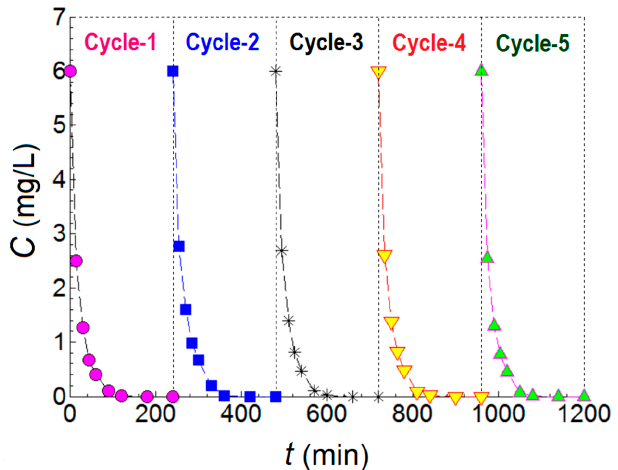
Figure 11. Reuse tests of the ciprofloxacin pollutant degradation in the presence of the ZNd2 sample (ZnO:Nd (0.1%)) for the fi ve evaluations under optimal conditions. A comparative analysis of materials based on ZnO doped with di ff erent elements (transition metals and lanthanides) is presented in Table 5. The photocatalytic activities of Nd-doped ZnO are superior to pure ZnO and comparable to or even be tt er than most reported state-of-the-art metal-doped ZnO photocatalysts. According to the data reported in this table, these materials have high degradation e ffi ciencies (~100%) after 120 min of visible light irradiation, with reaction rates reaching k = 4.780 × 10 − 2 min − 1 for MB dye deg- radation and k = 5.291 × 10 − 2 min − 1 corresponding to CIP pollutants. Another advantage of these systems was related to the light conditions, involving no acidi fi cation of solutions and/or the absence of H 2 O 2 , usually used to boost the photochemical reactions. Table 5. Comparative data of existing ZnO-based materials in the literature for the degradation of di ff erent pollutants. Catalyst, Dose